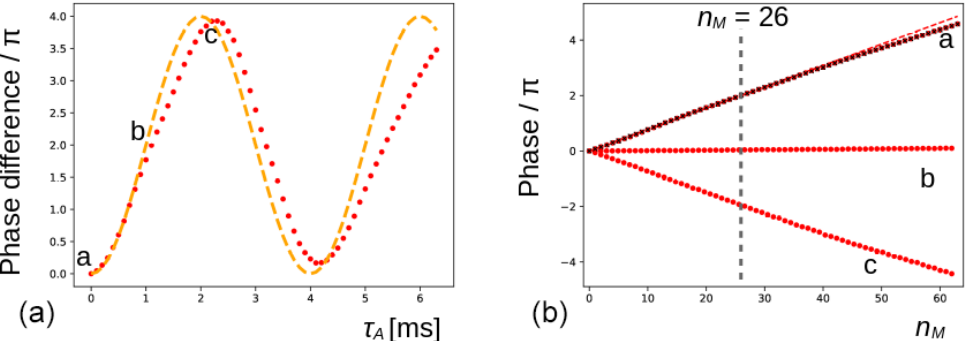
Figure 4. (a) The phase evolution of the methyl signal of DSS extracted from the experiment shown in Fig. 3b ( n M = 26). The duration of the preparatory pulse applied on H 2 O has been varied from 0 to 6.3ms with increments of 0.1ms (maximum nutation angle of ca. 3 π ). The orange dashed line shows the expected variation for an ideal RF pulse. (b) At positions a (0ms), b (1.1ms, no residual solvent magnetization), and c (2.2ms, inversion), the phase evolution of the signal is shown (red dots) for 0 ≤ n M ≤ 63 with increments of 1. The red dashed line corresponds to a linear fit of the first 32 points of a . The black crosses are recorded under the same conditions of a after inserting a bipolar gradient pair before and after the mixing period (as explained in Fig. 2) and are virtually undistinguishable from the red dots underneath.